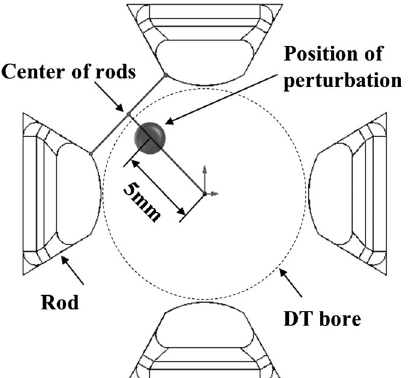
FIG. 5. A comparison of the measured and simulated E field strength along the axis of the new position of perturbation shown in Fig. 4. Both values of the measured and simulated E field in the RFQ shown in the figure were normalized to 1. In this figure, the rhombic and triangular symbols represent the measured and simulated values of the E field in the DT gaps, respectively.